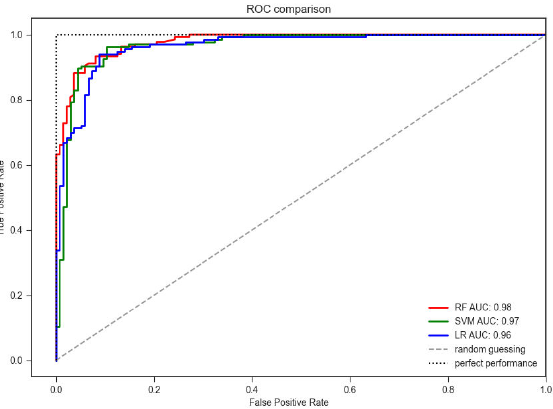
Figure 9. Plot of AUC–ROC curves for the ML model with Predictor Set II—with climate